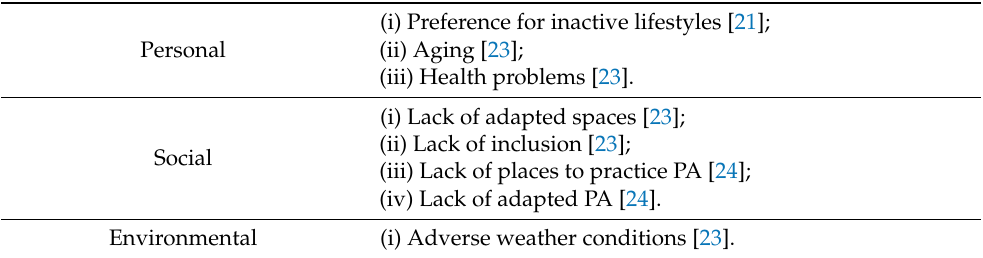
Table 3. Barriers to PA practice in the perception of individuals with ID.